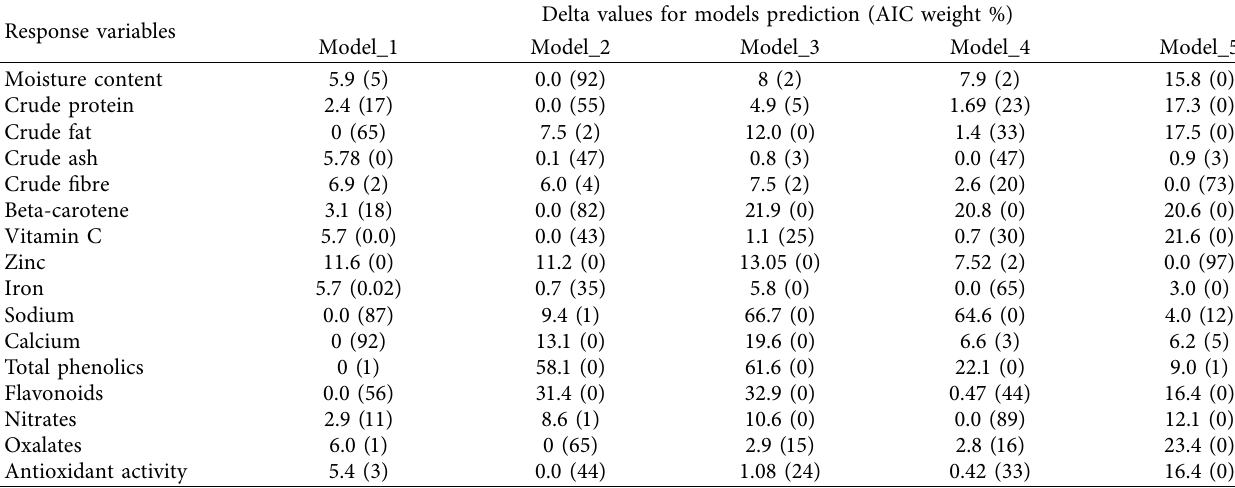
Table 7: AIC model selection criterion for independent factors afecting nutrient and antinutrient composition of cowpea leaves harvested at diferent maturity